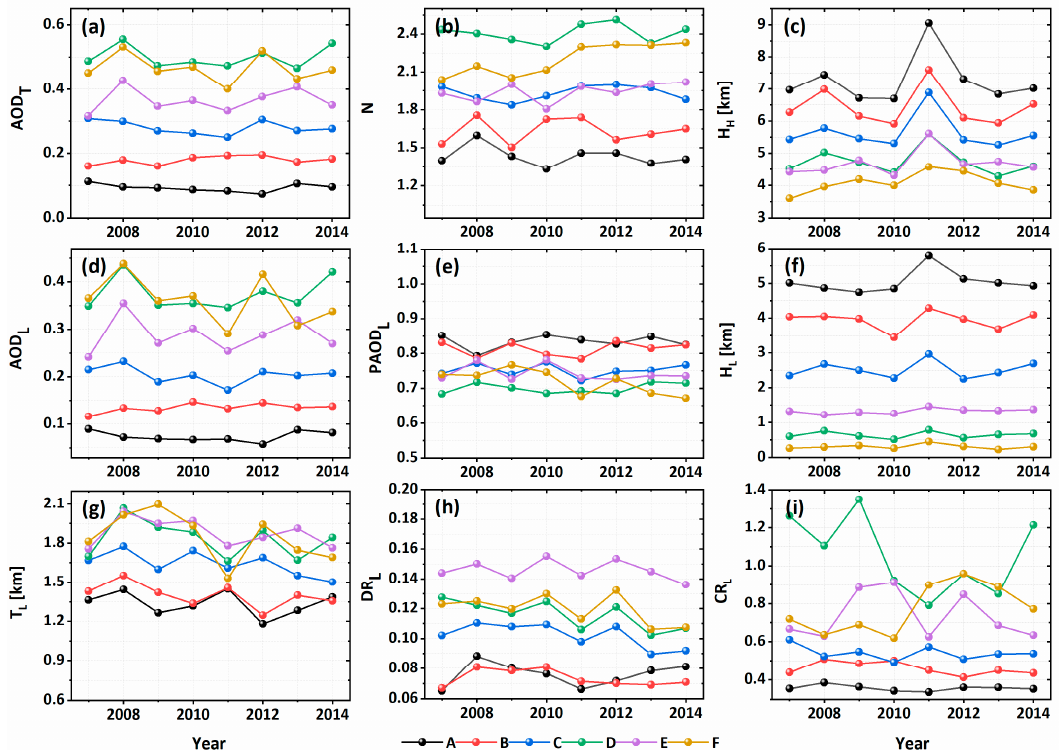
Figure 3. Interannual variations in the optical characteristics of aerosol layers over Pakistan (A: Gilgit-Baltistan, B: Jammu-Kashmir, C: Khyber-Pakhtunkhwa, D: Punjab, E: Balochistan, F: Sindh) during nighttime from 2007 to 2014. Where, ( a ) AOD T , ( b ) AOD L , ( c ) H L , ( d ) H H , ( e ) N, ( f ) T L , ( g ) PAOD L , ( h ) DR L , and ( i ) CR L .